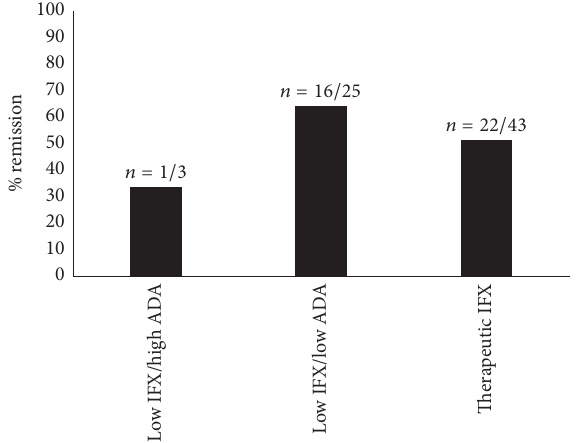
Figure 3: Remission at 6 months separated by group following infliximab therapeutic drug monitoring in inflammatory bowel disease patients with concerns for loss of response.